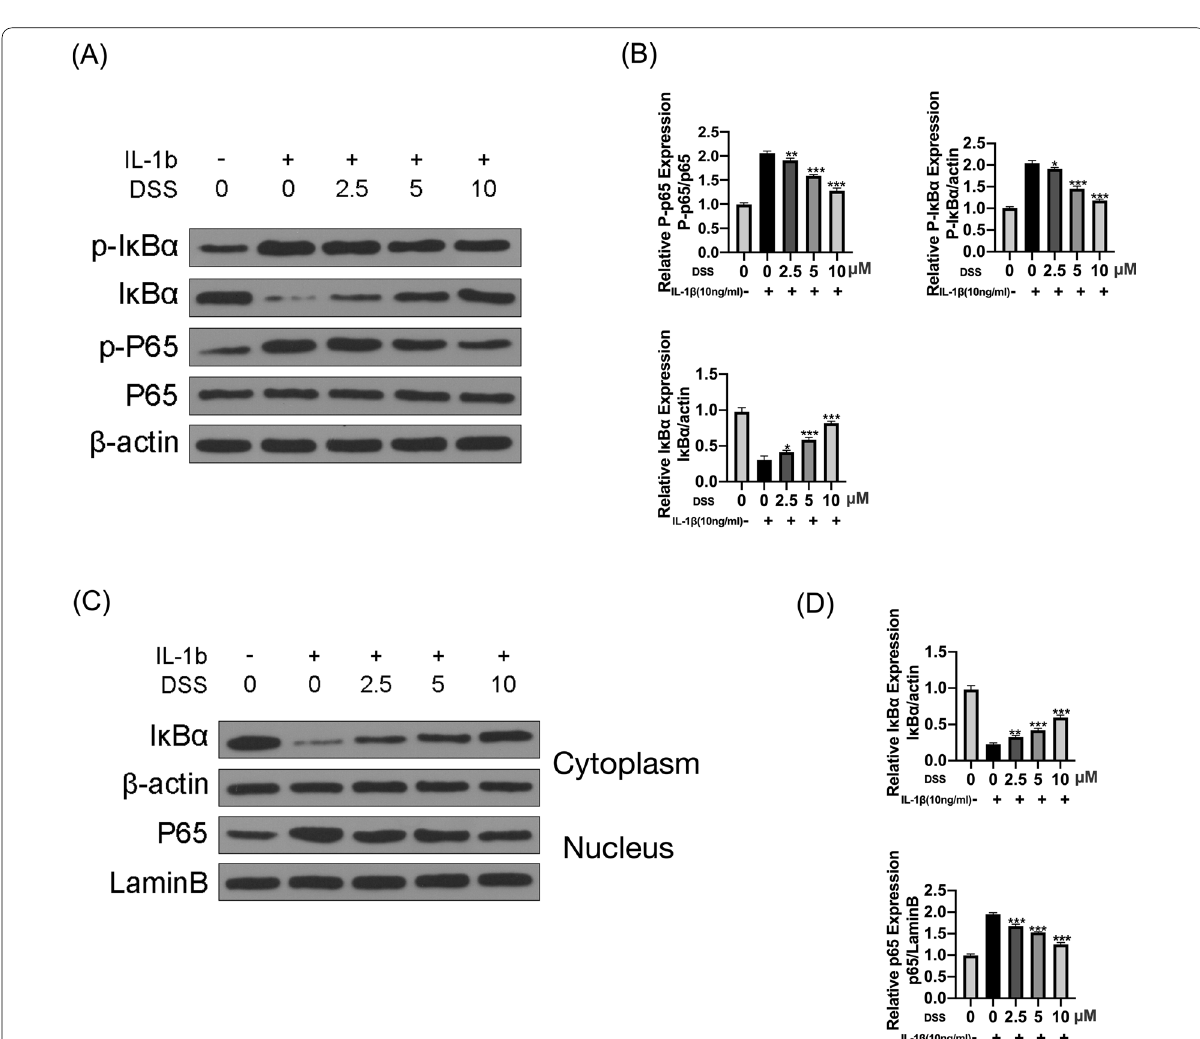
Fig. 4 DSS inhibited IL-1β-induced activation of the NF-κB pathway in chondrocytes. The chondrocytes were treated 2.5, 5 and 10 μM DSS for 24 h and then induced with or without 10 ng/ml IL-1β for 2 h. The protein levels of p65, p-p65, IκBα, and p-IκBα were detected by Western blot ( A ) and quantitative analysis ( B ). The protein levels of IκBα in the cytoplasm and p65 in the nucleus of chondrocytes were detected by Western blot ( C ) and quantitative analysis ( D ). *p < 0.05, **p < 0.01, and ***p <